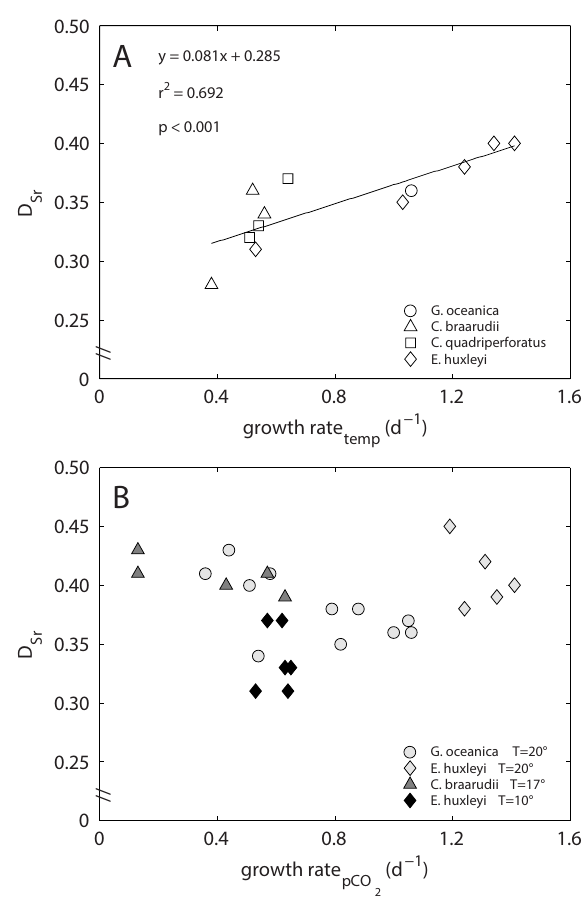
Fig. 3. Strontium partition coefficient ( D Sr ) as a function of growth rate (excluding the data from G. oceanica at 25 ◦ C). (A) Growth rate driven by changes in temperature ranging from 10 to 25 ◦ C ( p CO 2 = 370 ± 70µatm); black line indicates linear regression through all points. (B) Growth rate driven by p CO 2 ranging from ≈ 25 to 3520µatm (temperatures as